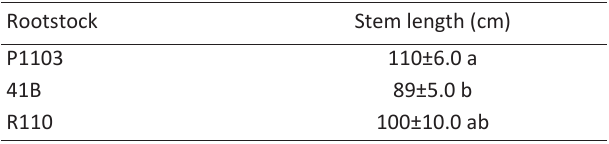
Different letters in a column indicate significant differences at P≤0.05 according to Fisher’s Protected